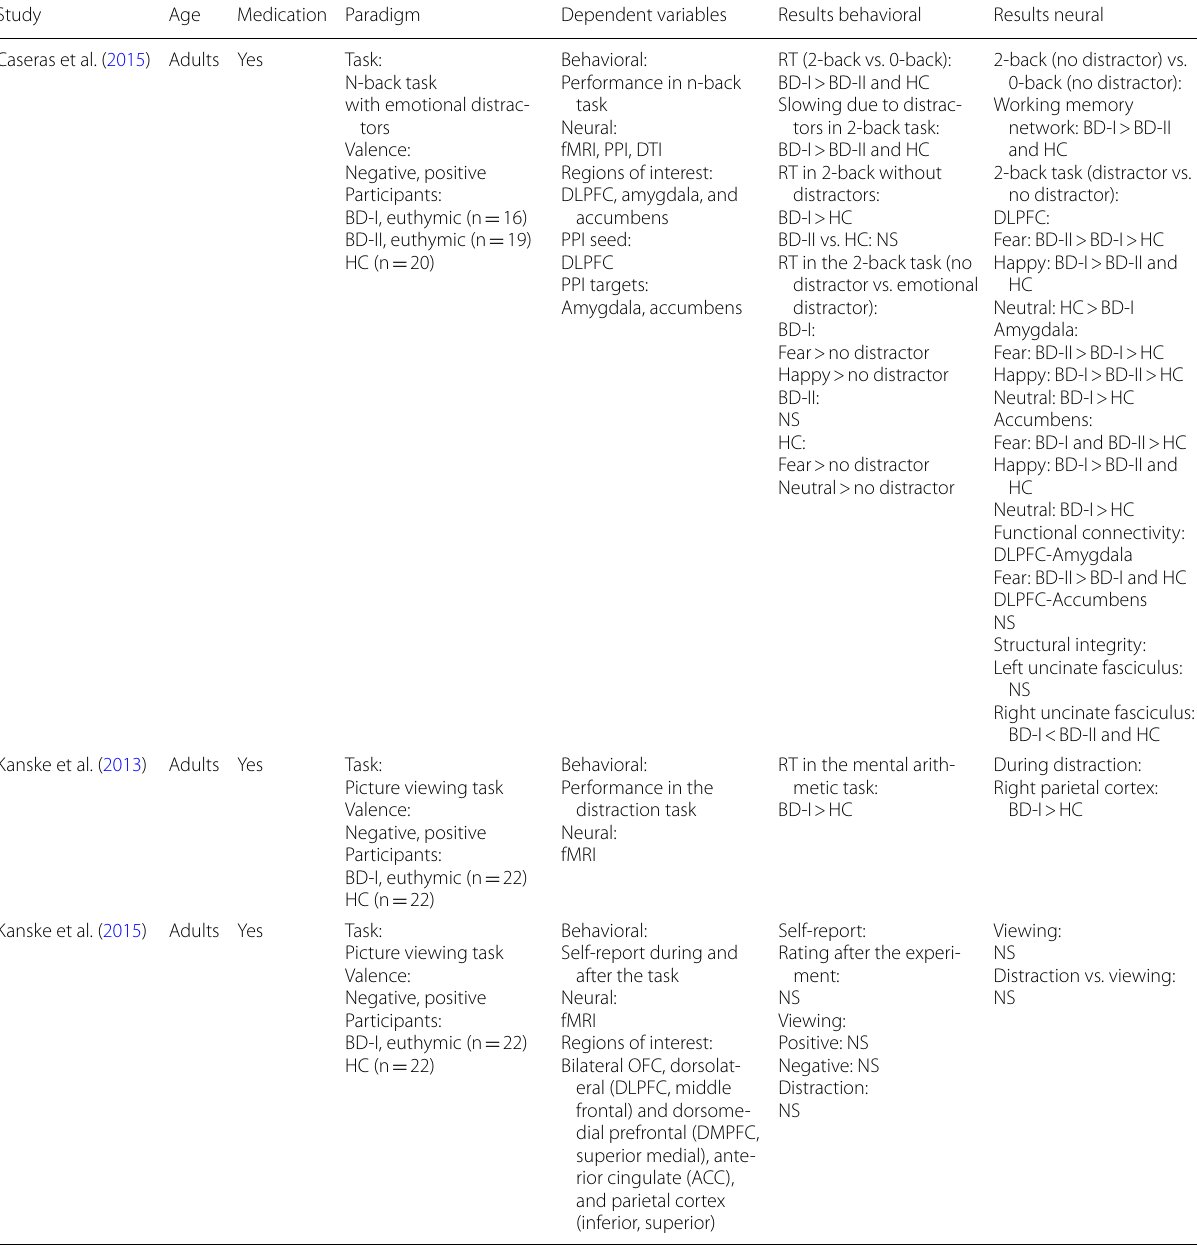
Table 3 Studies that investigated distraction in euthymic BD